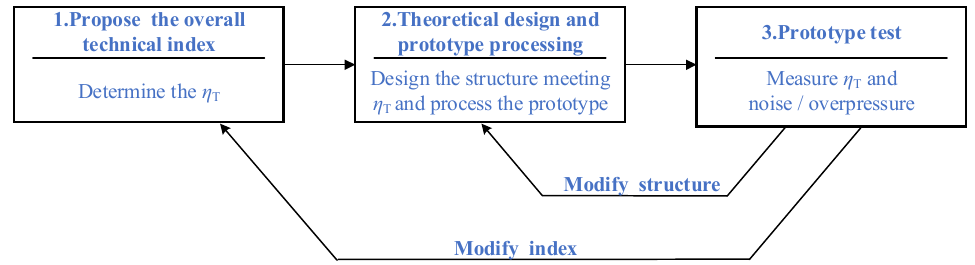
Figure 1. Steps of traditional design methods.